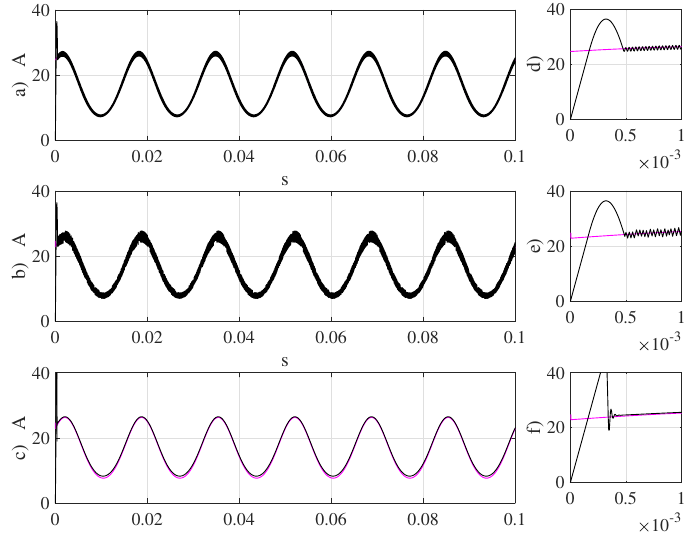
Figure 3. Output tracking of the inductor current. Reference signal in dashed line, and inductor current in solid line. ( a ) Proposed controller. ( b ) Controller in [8]. ( c ) Controller in